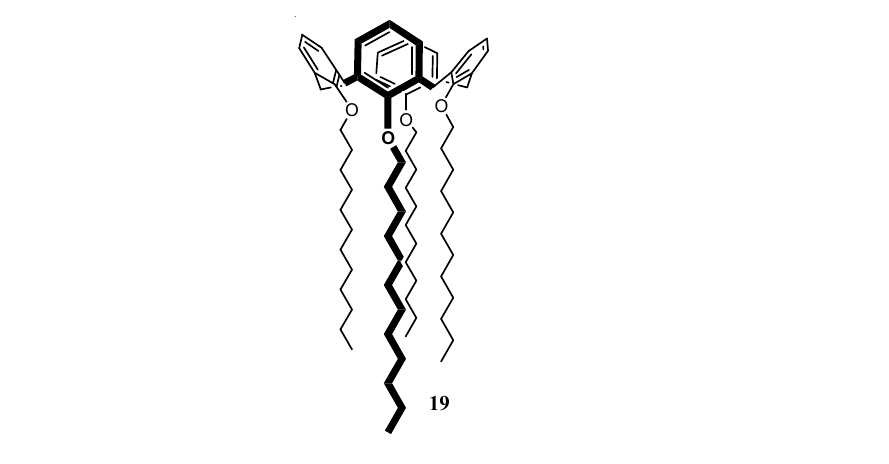
Figure 32. Molecular formula of para- H -tetra- O -dodecyl-calix[4]arene 19 .